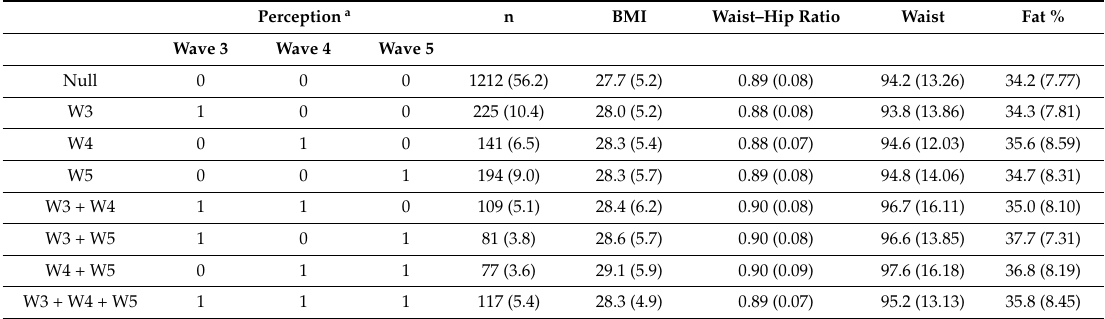
Table 2. Mean (Standard Deviation) adiposity outcomes by neighbourhood perceptions